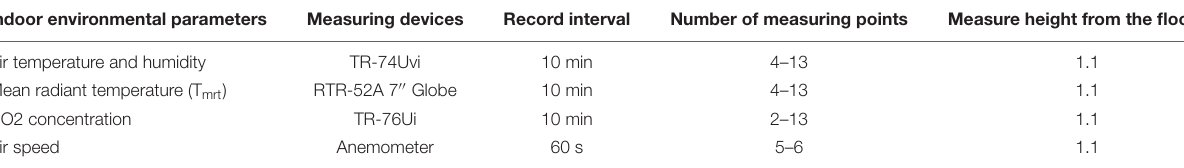
TABLE 2 | Methods and devices for measuring the thermal environment.